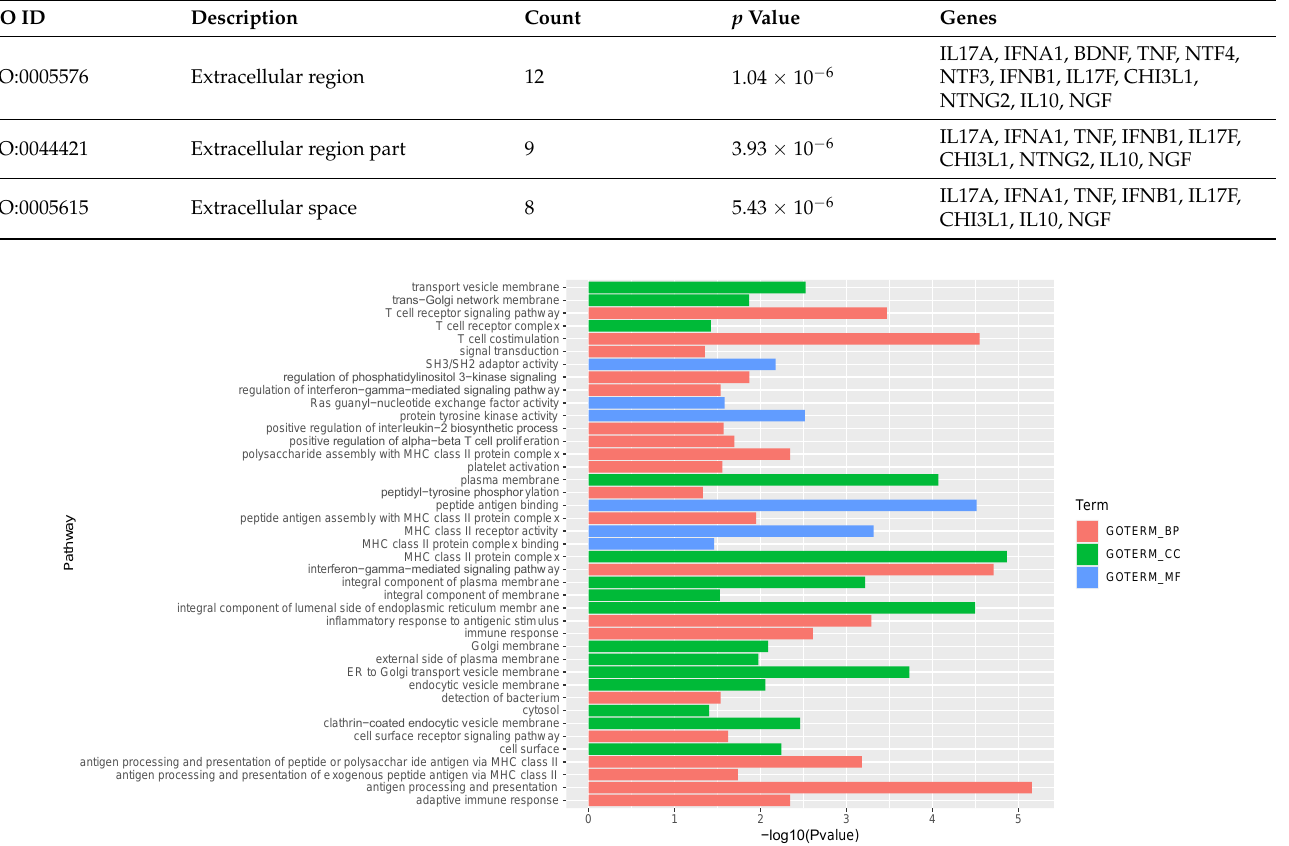
Table 3. GO analysis cell component (CC) of genes associated with cognitive dysfunction in MS.